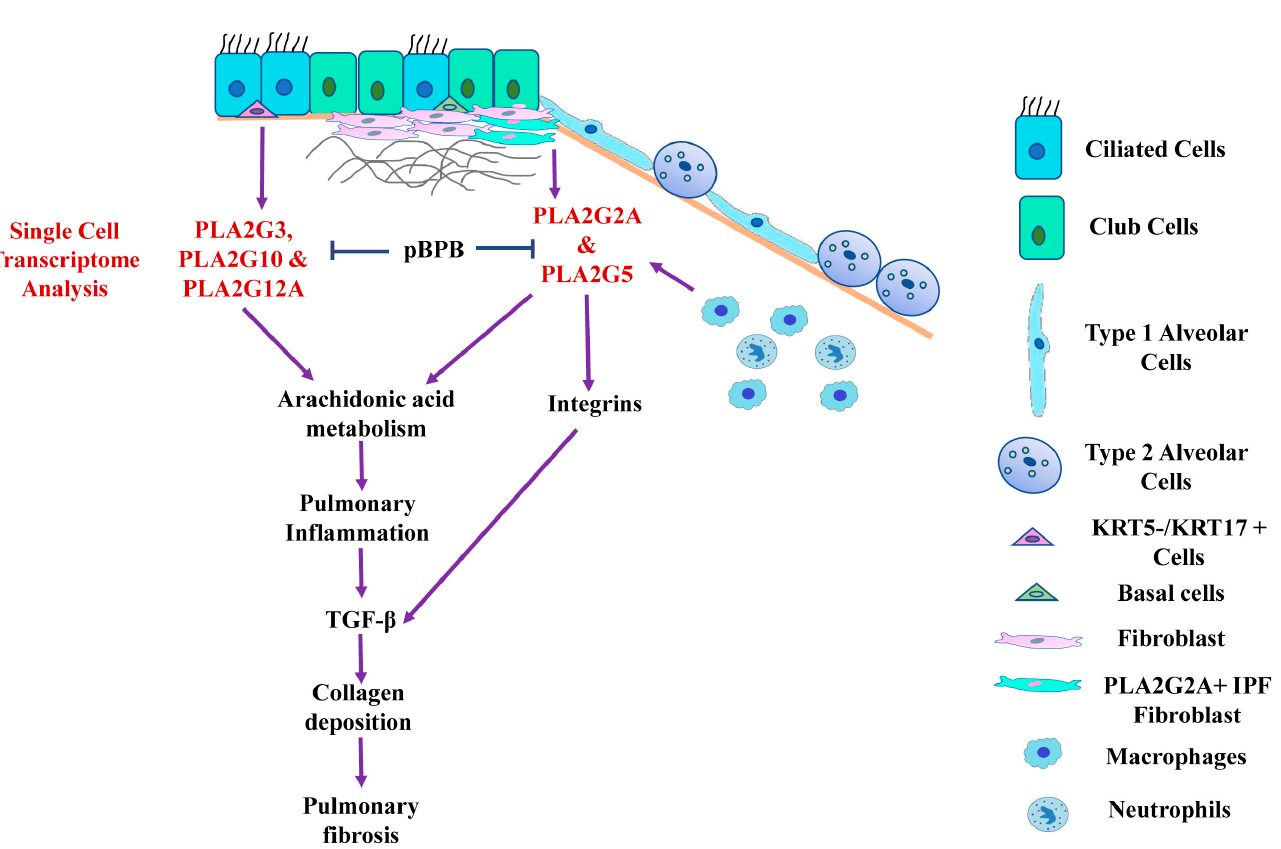
Figure 9. Schematic diagram showing the cellular distribution and possible role of sPLA2 in IPF patients and its inhibition in Bleomycin-induced mice. Single-cell transcriptome analysis revealed increased expression of PLA2G2A and PLA2G5 in fibroblasts, PLA2G10 in KRT5 − /KRT17+ cells and ciliated cells, PLA2G3 in KRT5 − /KRT17+ cells and club cells and PLA2G12A in club cells and ciliated cells of IPF patients. PLA2G2A and PLA2G5 can interact and activate integrins, which in turn activate TGF- β , the master regulator of pulmonary fibrosis. sPLA2 is involved in arachidonic acid metabolism and resulting metabolites can drive pulmonary inflammation and fibrosis. pBPB inhibit sPLA2 and attenuate certain features of fibrosis including collagen deposition and TGF- β in bleomycin-treated mice.